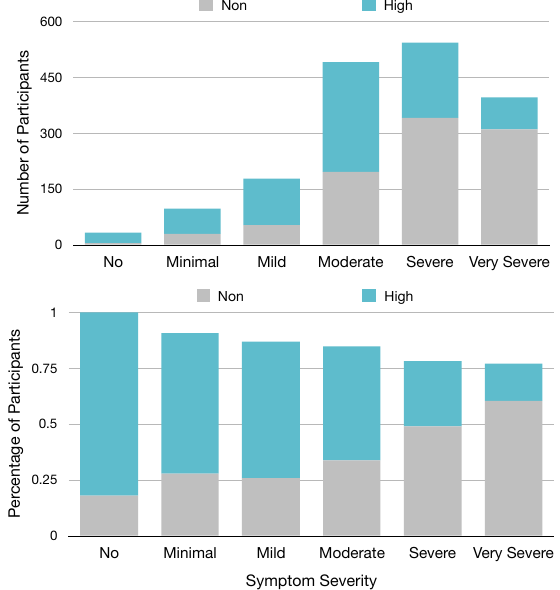
Figure 4. ( Top ) A stacked bar graph with participants from each GROC class by their answers to the severity of fatigue symptoms (Sx_Sev_1), increasing in severity. ( Bottom ) a normalized version of the bar graph that gives the percentage representation of each GROC class by response to Sx_Sev_1, for better visualization of trends. Note that, in the bottom plot, the bar plots do not sum to 1 due to the missing “low-responder”